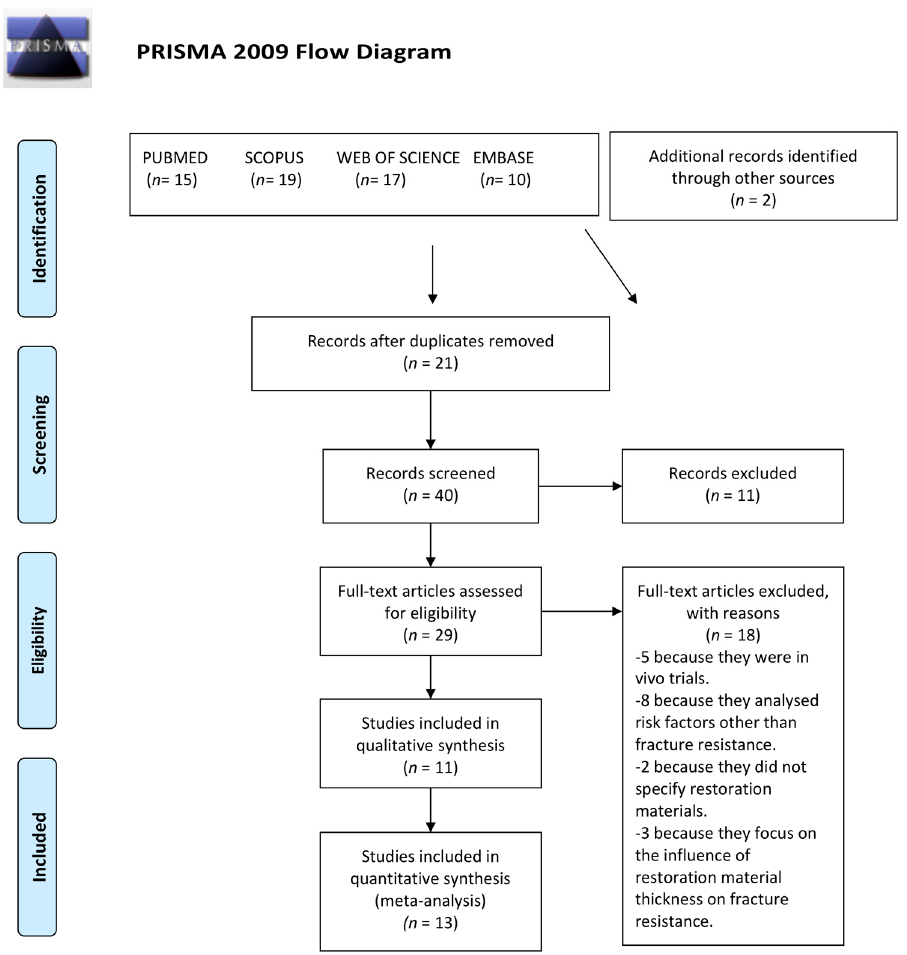
Figure 1. Flow chart of study selection procedure.